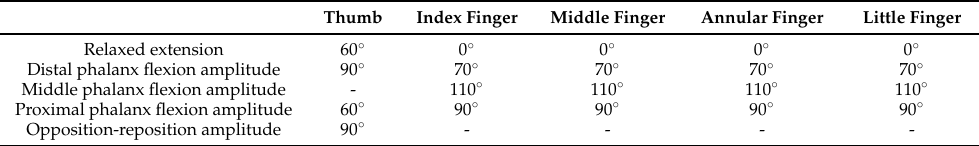
Table 4. Movements and amplitude for the prosthetic fingers. Source: Elaborated by the authors based on [46].